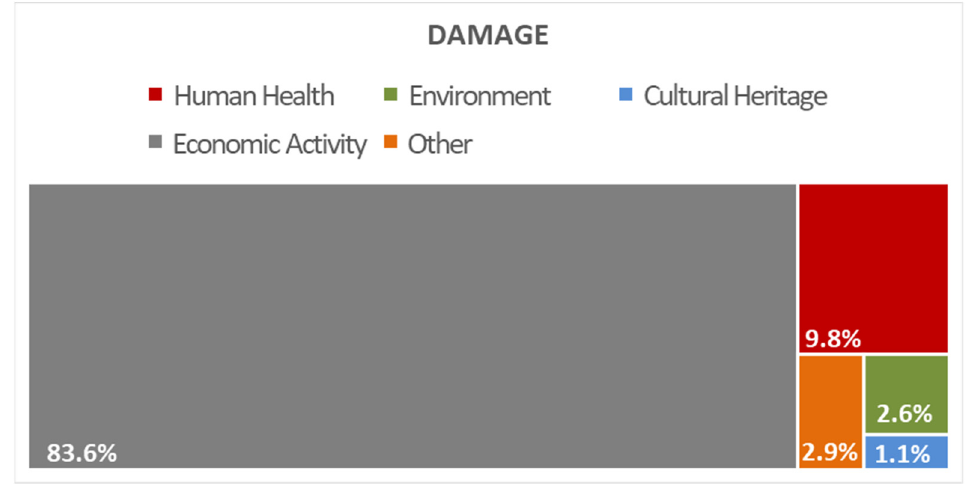
Figure 7. Damage caused by recorded sinkholes, according to the EU Floods Directive specifications.